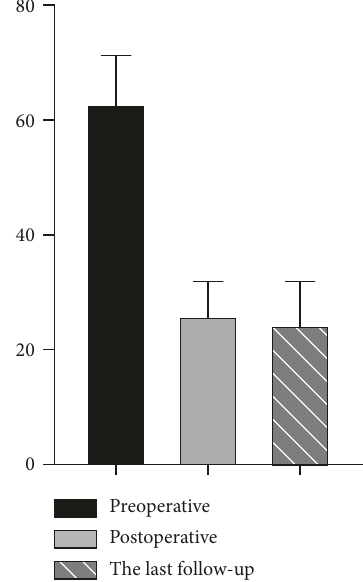
Figure 6: The comparison of ODI. Compared with preoperative, the postoperative ODI significantly decreased. But there existed no statistical difference in ODI reduction at the last follow-up com- pared with